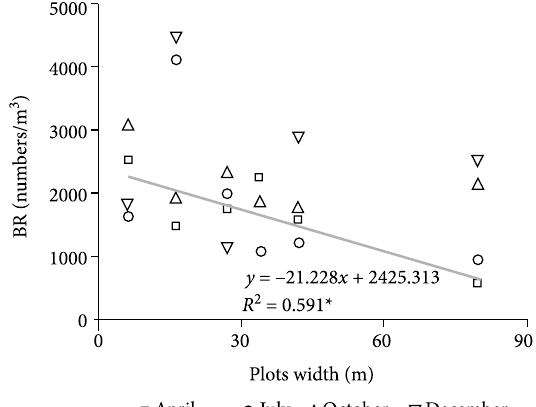
Fig. 15. Linear correlation analysis of average BR in green